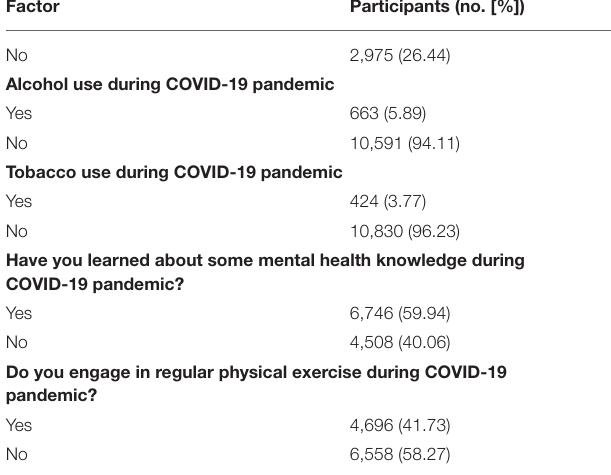
TABLE 1 | Descriptive statistics of demographic characteristics and pandemic-related information for students.